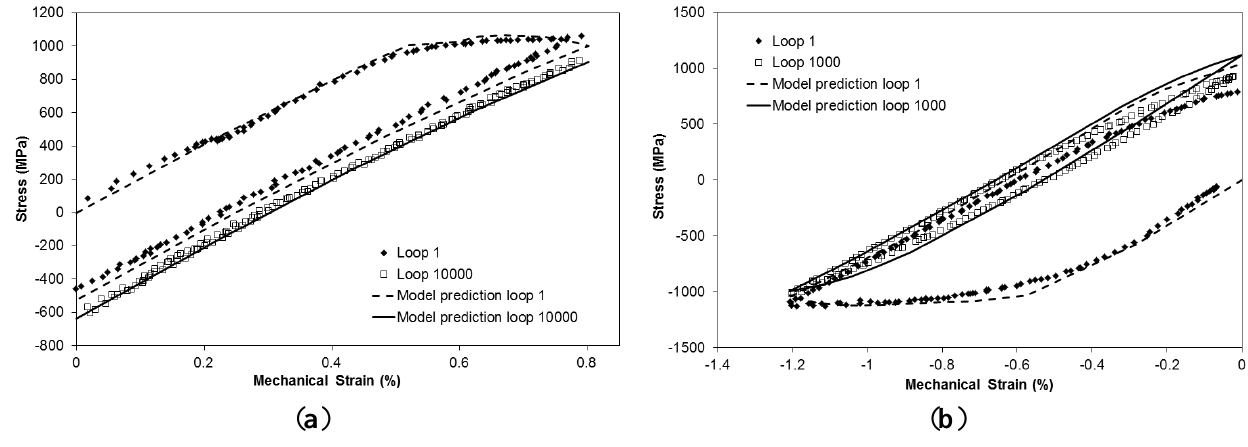
Figure 7. Modelling of TMF loops ( a ) IP Δε of 0.8%; ( b ) −180° OOP Δε of